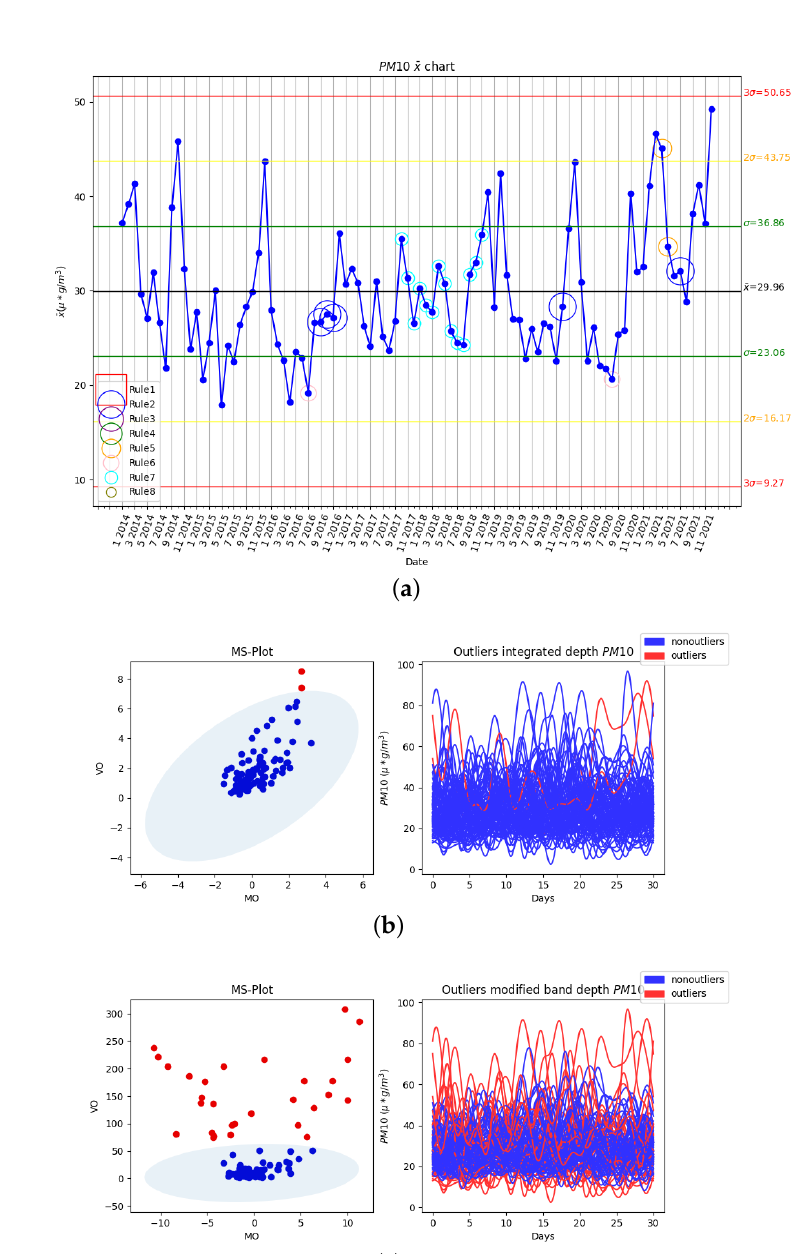
Figure 7. Results of the second phase of the PM 10 analysis: ( a ) ¯ x chart with the monthly rational subgroups and the Nelson rules implemented; ( b ) (left) Cartesian representation of the magnitude and shape outlyingness of each function with the integrated depth; (right) functional plot of the PM 10 values of each month; ( c ) (left) Cartesian representation of the magnitude and shape outlyingness of each function with the modified band depth; (right) functional plot of the PM 10 values of each